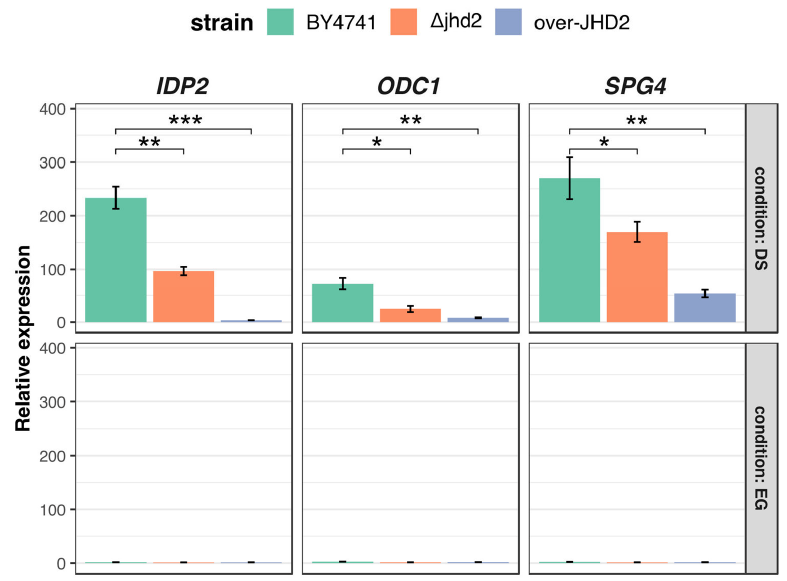
Figure 3. Real time RT-PCR quantitation of cDNA of IDP2, ODC1 and SPG4 at EG or DS for BY4741, ∆ JHD2 and over-JHD2 strains. n = 3, standard deviation is indicated. * = p < 0.05; ** = p < 0.01; *** = p < 0.001 according to Student’s t -test.